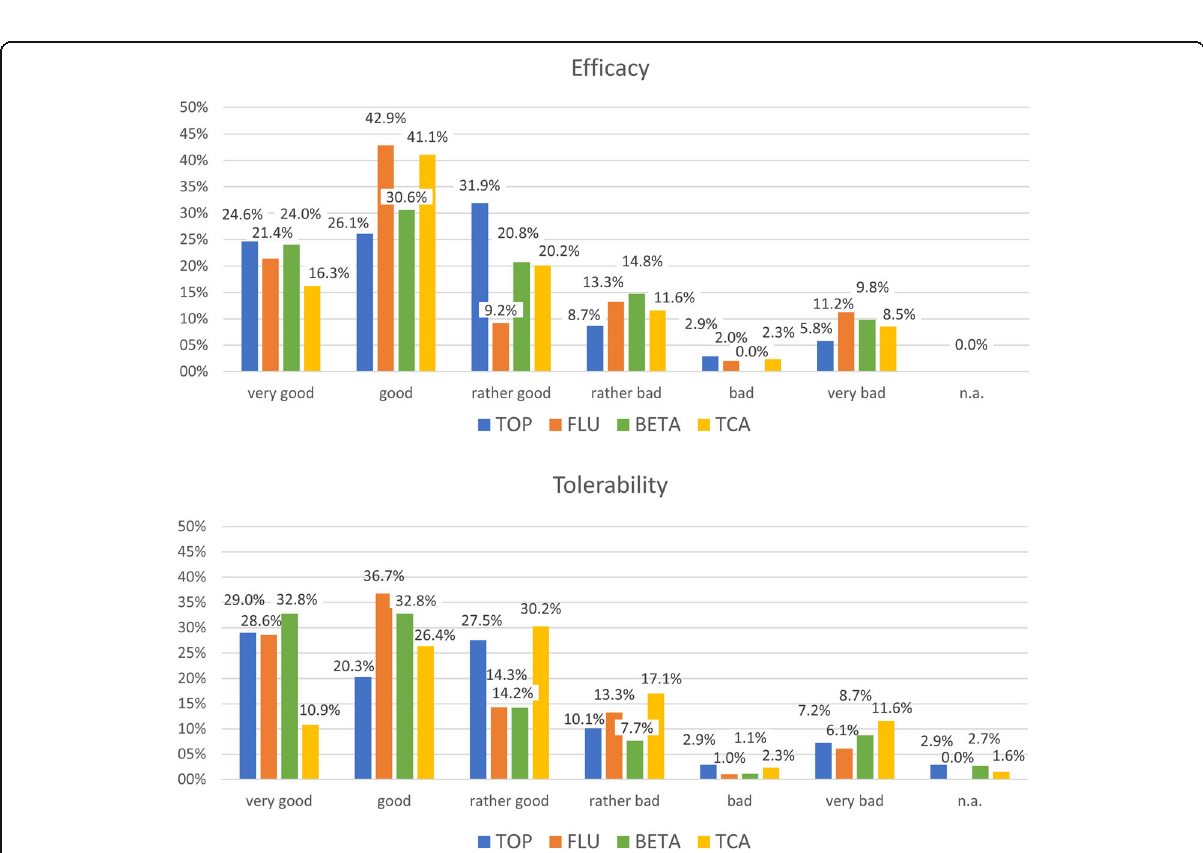
Fig. 3 Efficacy and tolerability of the four first-line preventative migraine medications as evaluated by the clinicians during the second consultation (3 – 6months after first consultation). TOP: topiramate, FLU: flunarizine, BETA: beta blockers, TCA: tricyclic antidepressants. ( n =647). n/a: not applicable